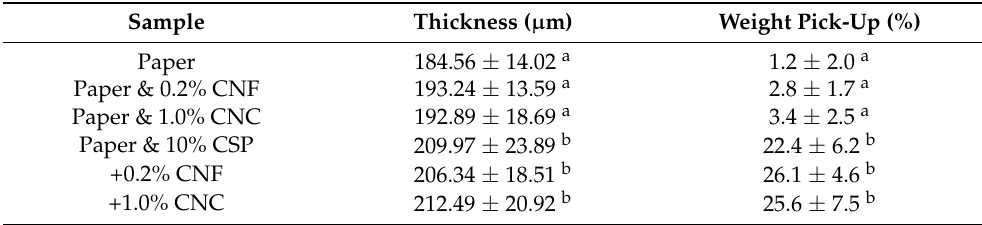
Table 1. Physical properties of paper samples treated with cottonseed protein and nanocellulose for-